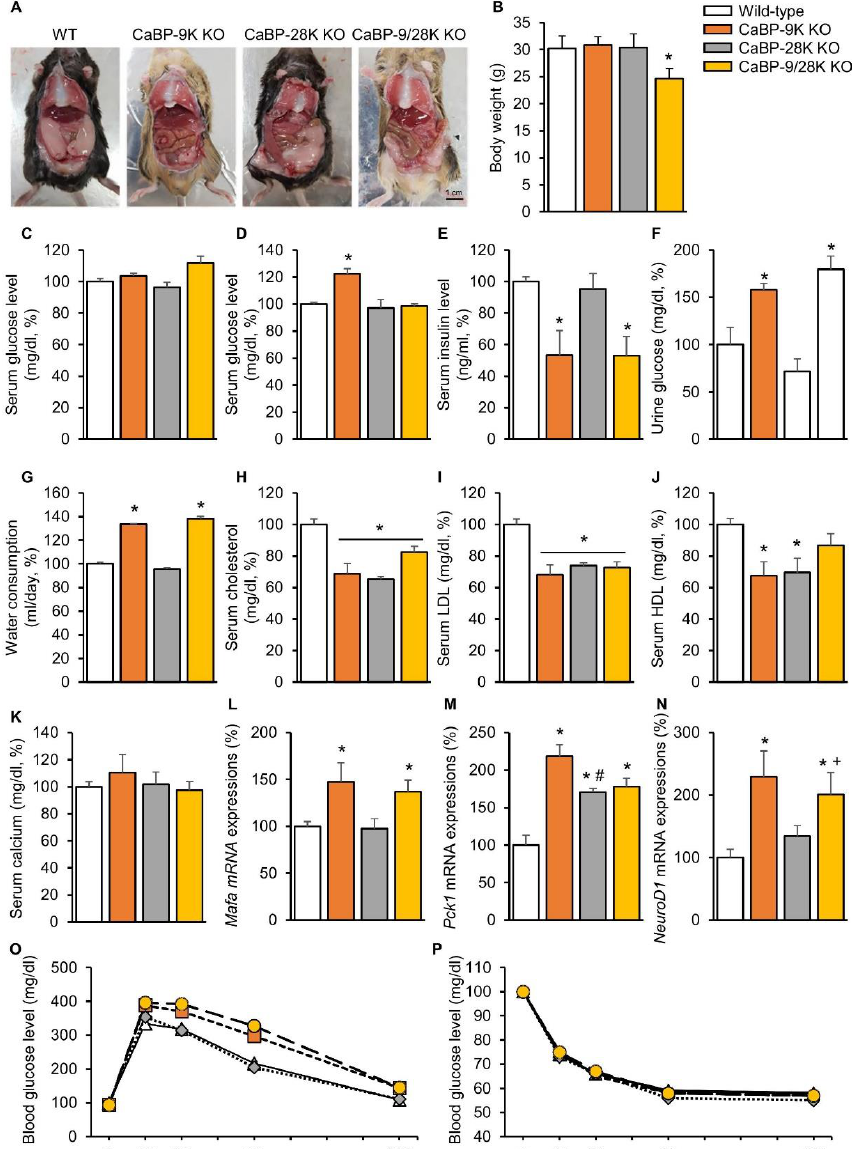
Figure 1. The e ff ects of CaBP-9k, 28k, and 9 / 28k ablation on glucose metabolism. Abdominal adipose tissue deposition in mice ( A ), body weights of mice ( B ), serum glucose level in a fasting state ( C ), serum glucose level at resting state ( D ), insulin level ( E ), urine glucose level ( F ), water consumption ( G ), serum cholesterol ( H ), serum low-density lipoprotein (LDL) level ( I ), serum high-density lipoprotein (HDL) level ( J ), serum calcium level ( K ), insulin dependent transcription factor in liver Mafa ( L ), Pck1 ( M ), NeuroD1 ( N ), mRNA expression and glucose tolerance test ( O ), and insulin tolerant test result ( P ). Values are expressed as means ± SDs; * p < 0.05 versus WT; # p < 0.05 versus CaBP-9k knockout (KO); + p < 0.05 versus CaBP-28k KO. Scale bar = 1